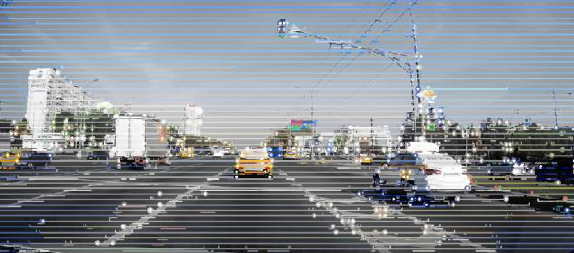
Figure 3 . Color bunches corresponding to a scene with traffic lights.